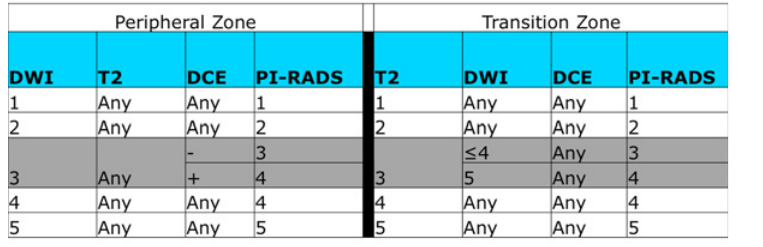
Fig 2. PI-RADS Scoring System.